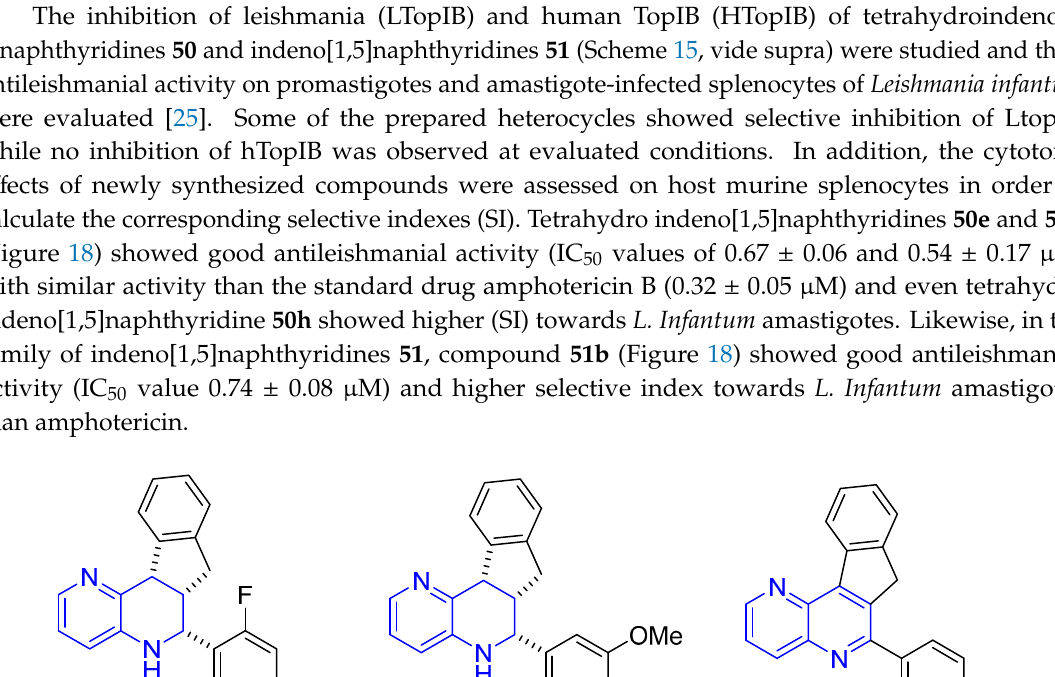
Figure 17. β -Hematin inhibition of 21 .